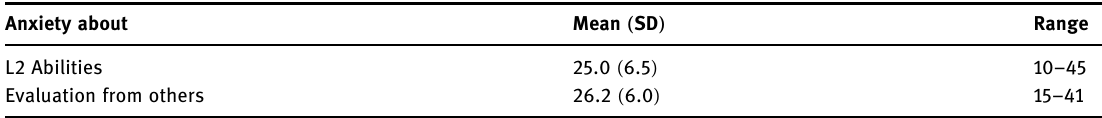
Table 3: Willingness to speak L2 English under two types of anxiety ( Likert points ) Anxiety about Mean ( SD